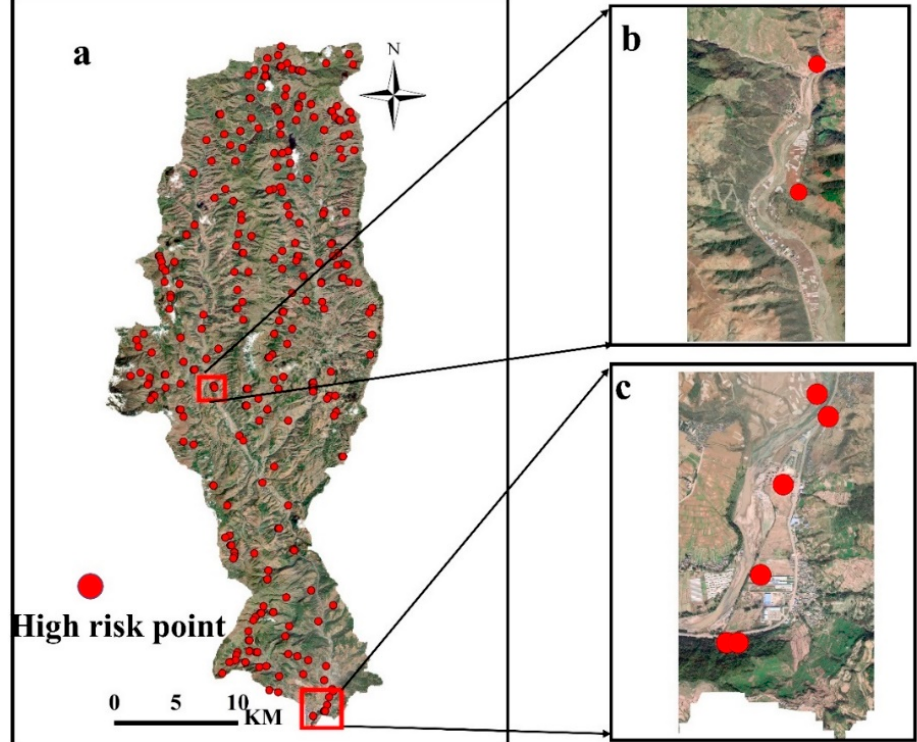
Figure 12. Maps of flood risk loci based on maximum water depth: ( a ) all high risk points in the basin; ( b ) the zoomed-in views of the high risk points in the mid reach of the basin; ( c ) the zoomed-in views of the high risk points in the downstream of the basin.